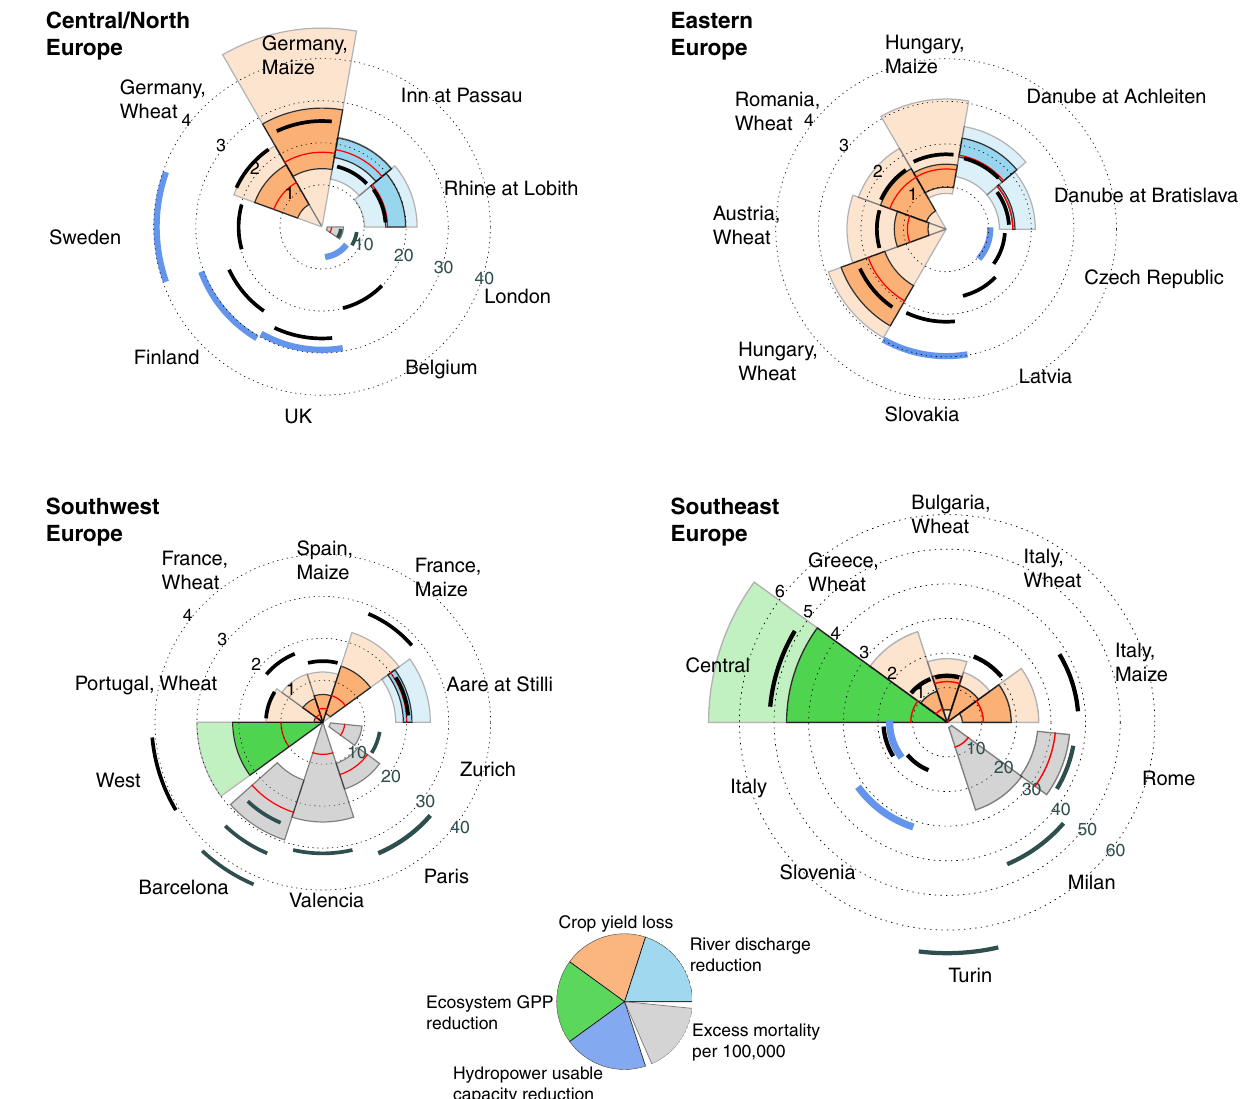
Fig. 1 Multi-sector impacts of the 2003 EHWD. Black arcs represent observations, and colours represent model results. Units are standard deviations (black axis labels), except for human mortality which is given in excess deaths per 100,000 (grey axis labels). For river discharge, crop yields and ecosystem GPP, the thin red line marks the multi-model median; the dark-coloured segment marks the interquartile range; and the light-coloured segment marks the full range of model results. For hydropower, only one model is available which is marked by the thick blue arcs. For mortality, the red line and grey segments mark the median and the full range, respectively, across three climate forcing data sets and three different heat-mortality relations. Note the larger axis range for Southeast Europe. This fi gure only includes river discharge, crop yield, GPP and hydropower results for those locations where a negative anomaly larger than 1 standard deviation was observed. Figures 2 – 6 include further details on the data shown here, as well as additional data for locations with smaller or positive anomalies. The West and Central regions used for ecosystem GPP are de fi ned in